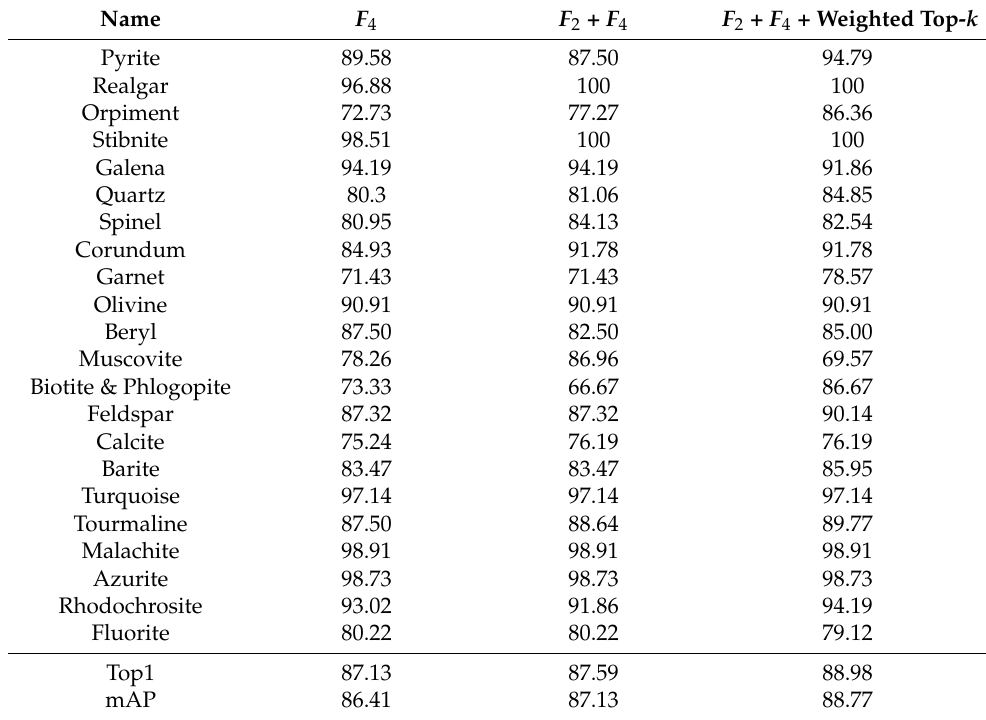
Table 5. The Top1 accuracies of minerals obtained by three methods